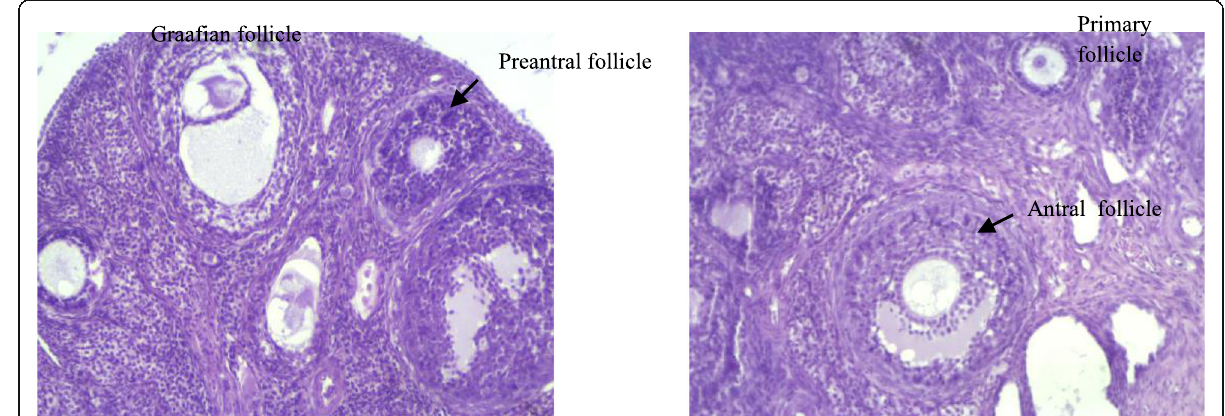
Fig. 2 Cross-section of rat ovary in the control group (× 100, H&E). Primary, preantral, antral, and Graafian